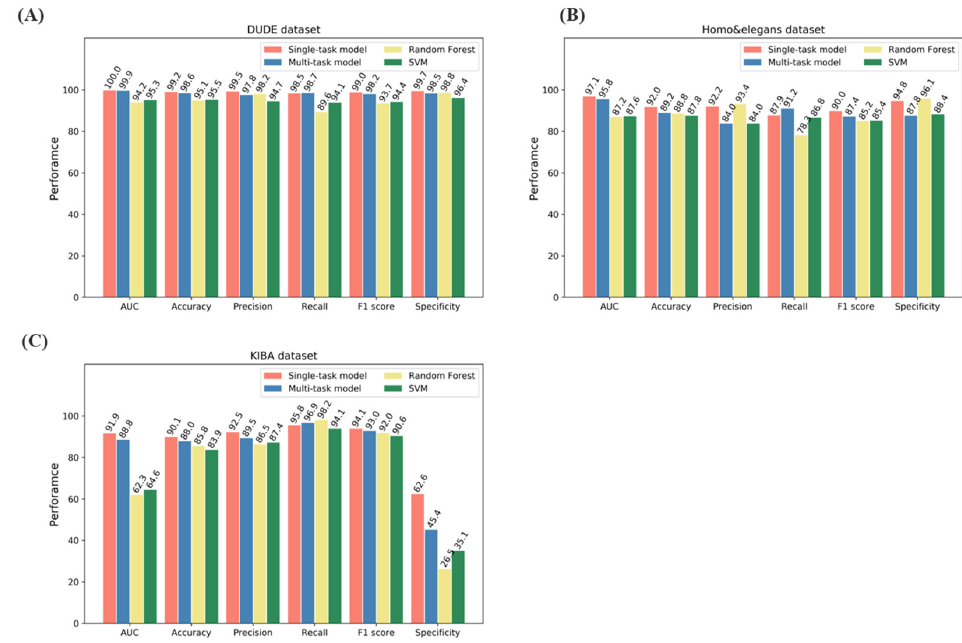
Figure 3. Model performance on ( A ) DUD-E. ( B ) Human and C. elegans. ( C )KIBA